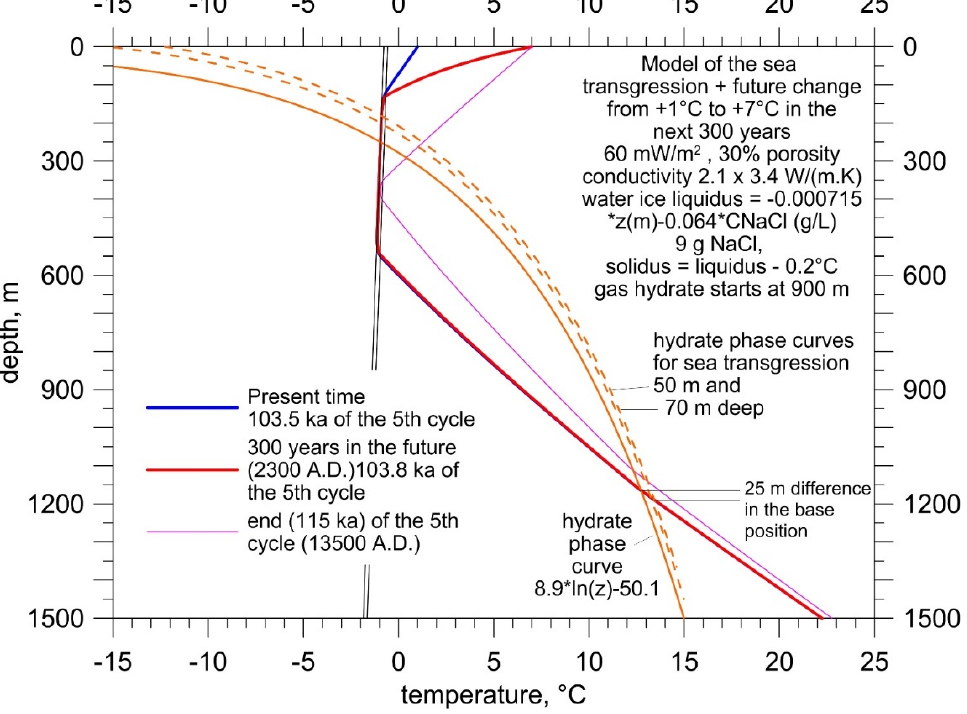
Figure 5. Offshore Beaufort model results where the marine transgression water depths are either 50 m or 70 m. Note that relict permafrost and GH remain stable in this BMB